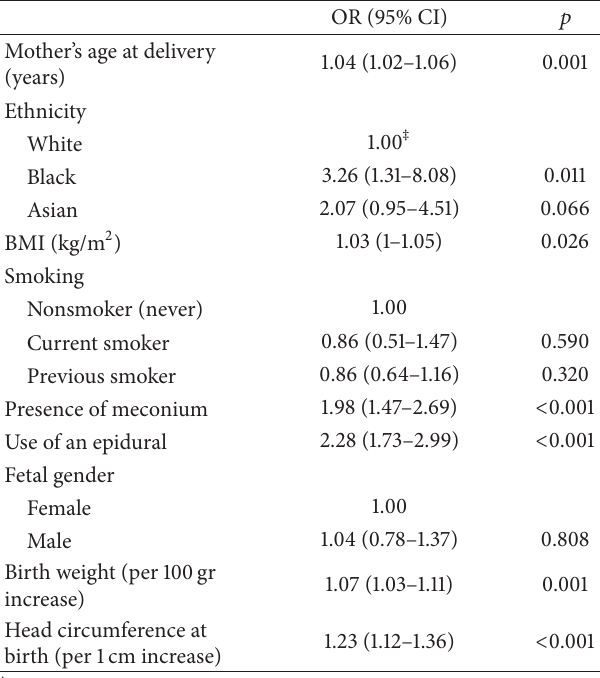
Table 3: Odds ratios (OR) and 95% confidence intervals (CI) derived from multiple logistic regression analysis for caesarean section in relation to demographic and perinatal